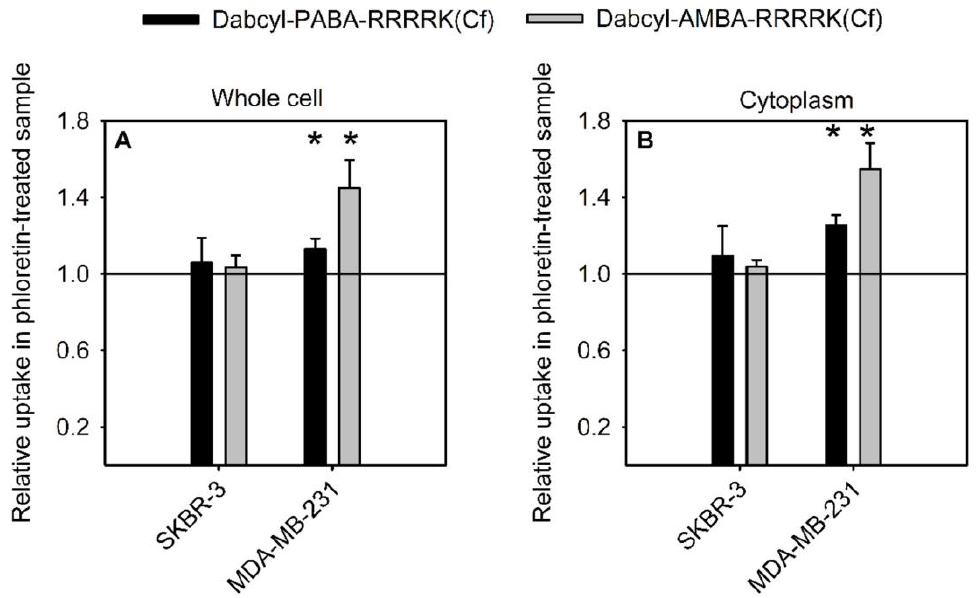
Figure 11. The uptake of peptides is influenced by the dipole potential. Cells were pretreated with 100 µ M phloretin in the presence of 0.05% ( v/v ) Pluronic F-127 to decrease their dipole potential followed by incubating them with 5 µ M peptide for 20 min. The fluorescence intensity of the peptides in the whole cell or in the cytoplasm was determined and normalized to the intensities of cells pretreated with Pluronic F-127 only. The results represent the mean ( ± SEM) of three independent biological replicates. Statistical significance was tested by two-way ANOVA followed by Sidak’s multiple comparison test, and the asterisks show a significant effect of phloretin treatment according to the posthoc test (* p < 0.05).